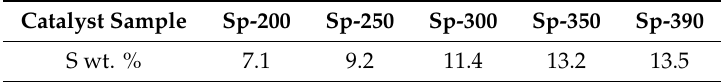
Table 6. Sulfur content in the catalysts after Py-SS hydrotreatment at 200–390 ◦ C. Catalyst Sample